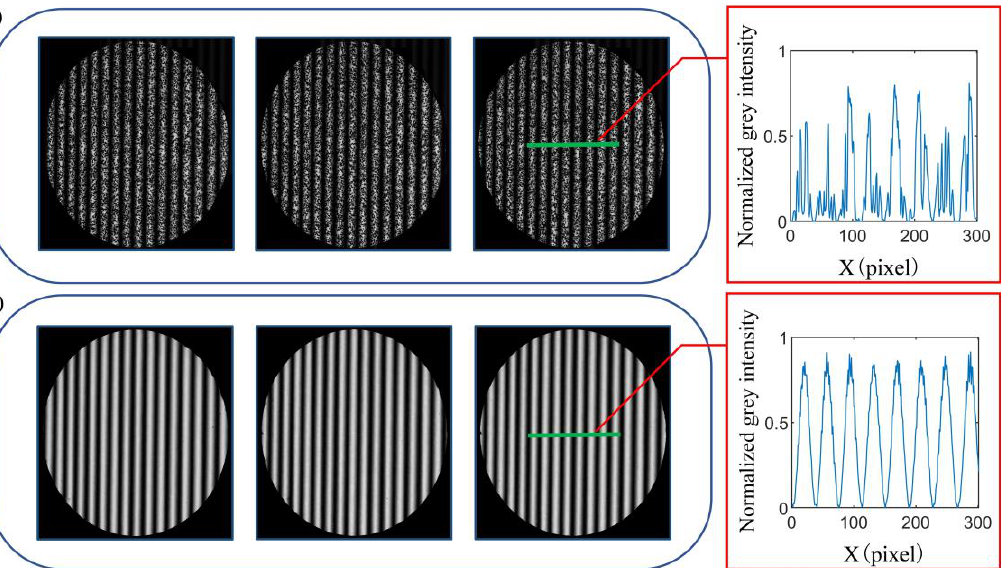
Figure 5. Experimental results. ( a ) The input speckle-embedded fringe images of CNN and grey intensity; ( b ) the output speckle-free fringe images of CNN and grey intensity.